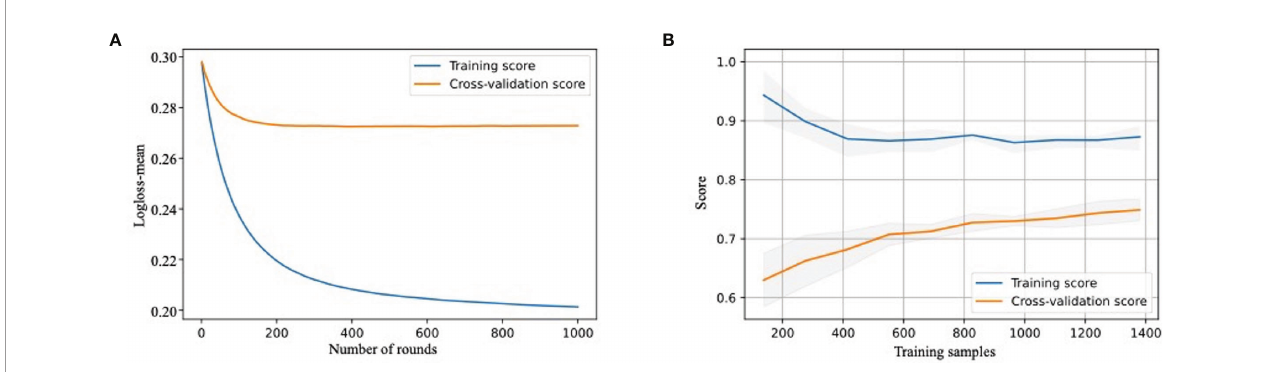
FIGURE 2 | Development and validation of MVI-prediction model (A) The training process of XGBoost model. Train-log-loss-mean value for the training datasets is shown in the vertical axis. The horizontal axis represents the number of times iterative cross-validation. (B) The learning curve of the score of training cohort and testing cohort. The score for training and test cohorts is shown in the vertical axis. The horizontal axis represents the number of samples trained.